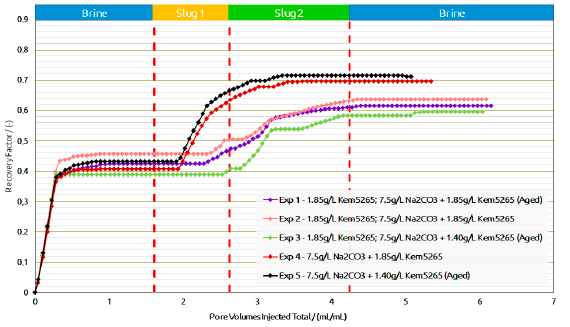
Figure 15. Recovery factor versus pore volumes injected total for the different slugs for core floods in Berea outcrops. Berea Core Flood Experiments in Real Rock: Selected formulations from core flood experi- ments were further injected in reservoir sand packs, as shown in Figure 16 and Table 10.